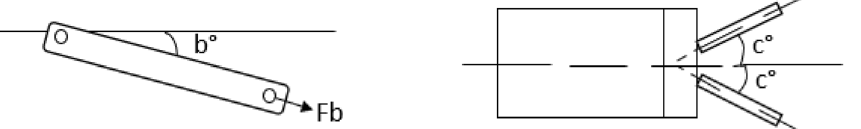
Figure 7. Diagrams showing the direction of the force in the lower/bottom